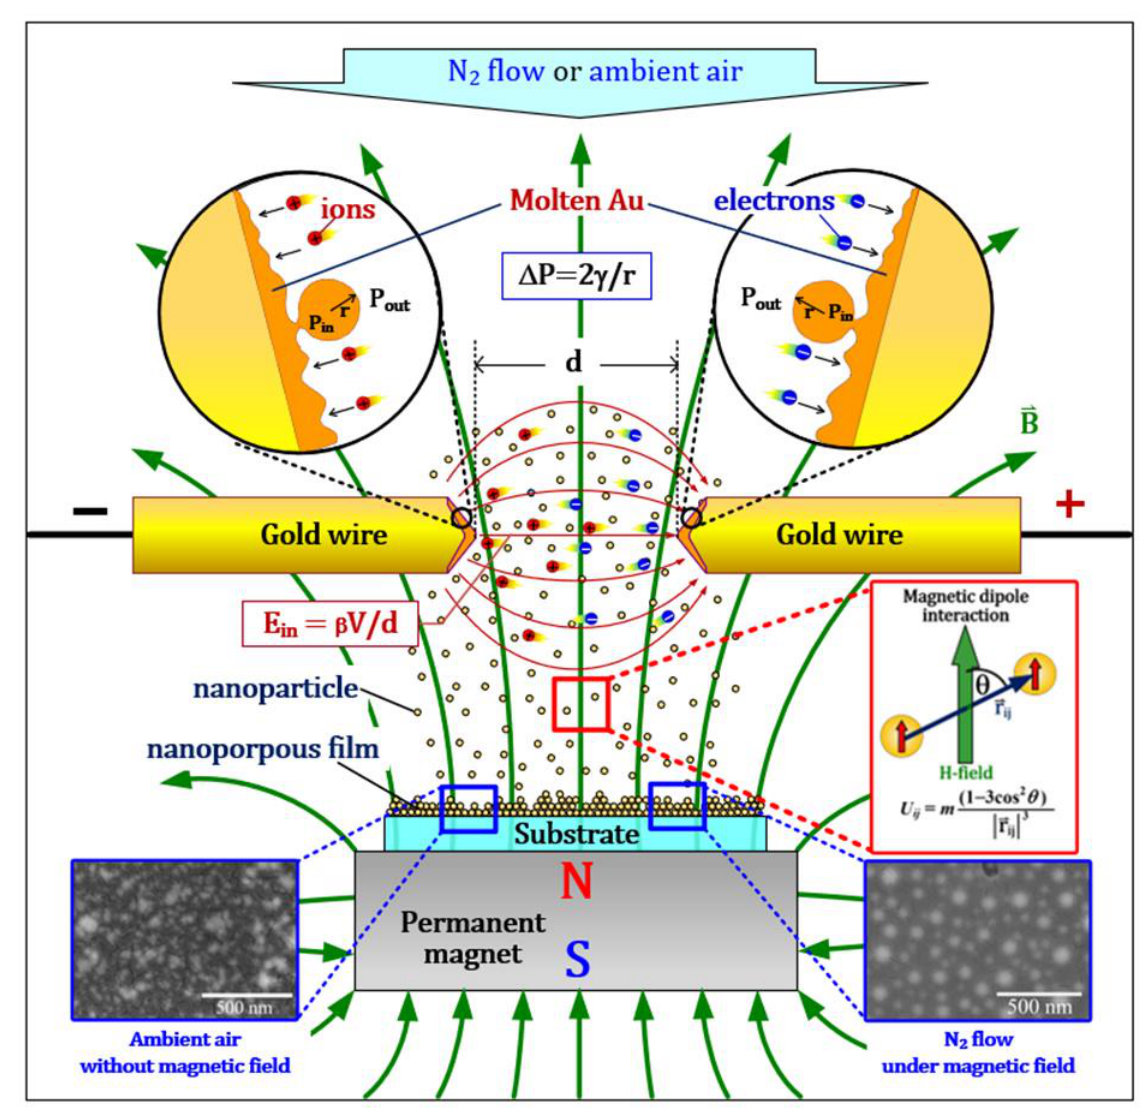
Figure 8. Schematic representation of chemical process in our experiment, modified from refer- ence [20,22]. Gold wires are evaporated using high voltage and particles produced by melt were collected on quartz substrate put on permanent magnet. The high pressure and temperature on the tip surfaces were generated by the bombardment of electrons and ions. Particle size relation is described by Young–Laplace equation, i.e., ∆ P = 2 γ / r , where r is the radius of curvature, γ is the surface energy of the molten metallic tip, and ∆ P is the pressure difference between the inside ( P in) and the outside ( P out) of the